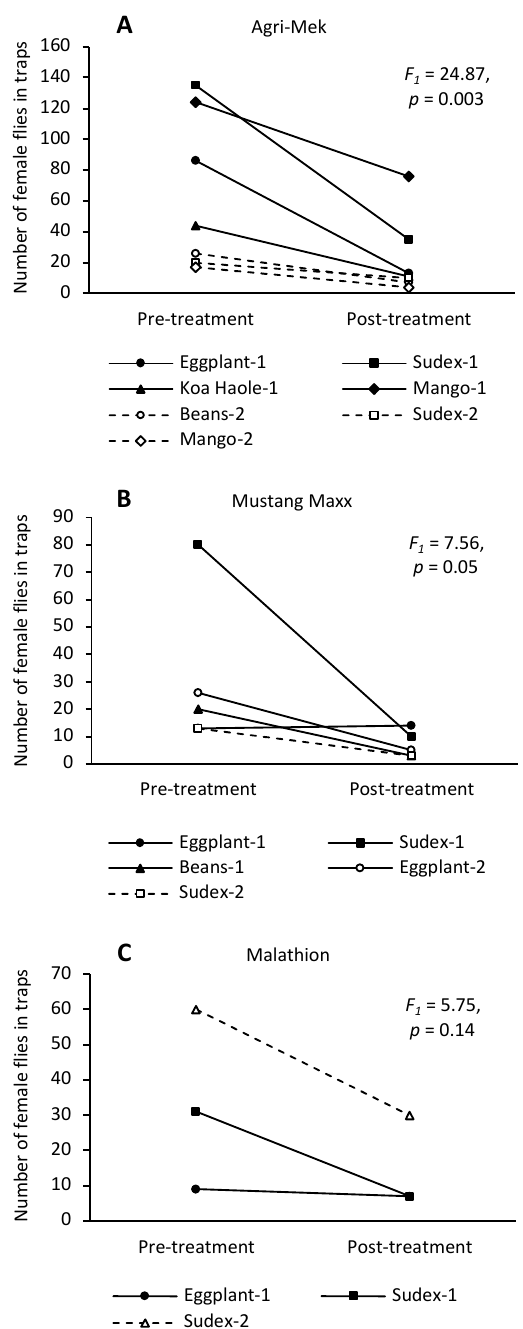
Figure 2. The numbers of female Zeugodacus cucurbitae caught in torula yeast traps on roosting plants in the two days prior to insecticide application and two days after application at the Maui research station ( A , Agri-Mek SC; B , Mustang Maxx; C , Malathion 5EC).